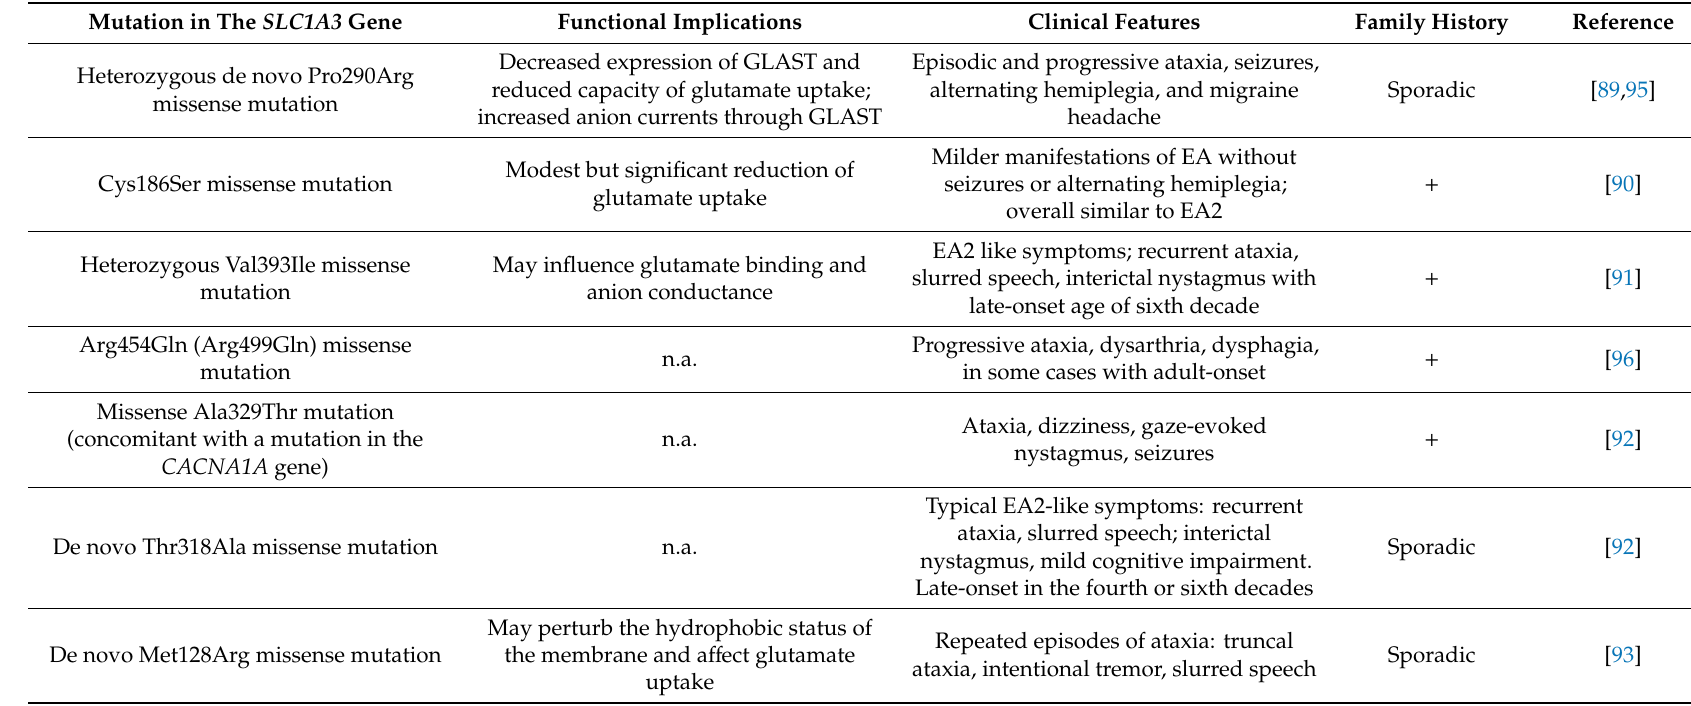
Table 2. Mutations in the SLC1A3 (Solute Carrier Family 1 Member 3) gene cause episodic ataxia 6 (EA6). Distinct missense mutations, either inherited or sporadic, were identified in the SLC1A3 gene in patients with EA. This syndrome was designated as episodic ataxia 6 (EA6), although it shared many overlapping clinical features with EA2, identified by the presence of heterozygous pathogenic variants in the CACNA1A (calcium voltage-gated channel subunit alpha1)